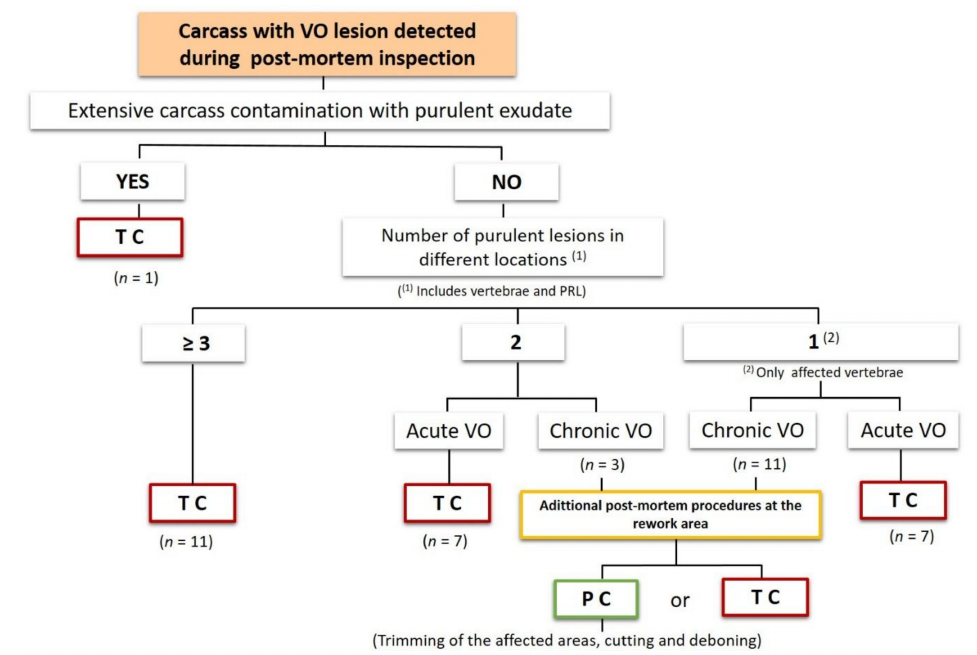
Figure 2. Second proposal of the scheme to classify vertebral osteomyelitis (VO) as generalized or as localized cases that should lead respectively to total and partial condemnation. PRL—pyemia-related lesions; C—chronic; A—acute; TC—total condemnation; PC—partial